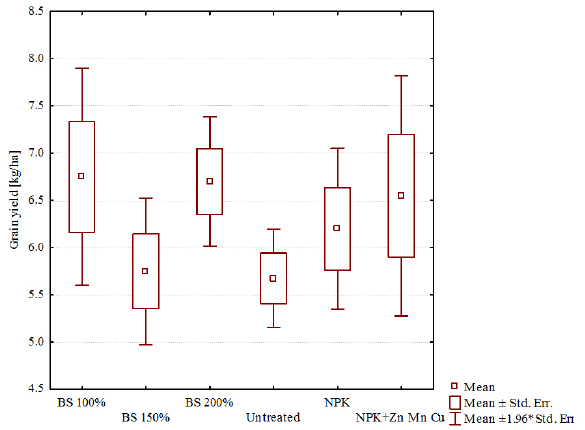
with different doses of micronutrients delivered with blackcurrant seeds (7.3 and 7.2 Mg ha -1 for BS 100% and BS 200%, respectively) was higher than in case of the control group (6.2 Mg/ha) and similar to the group treated with commercial product (7.1 Mg ha -1 ).